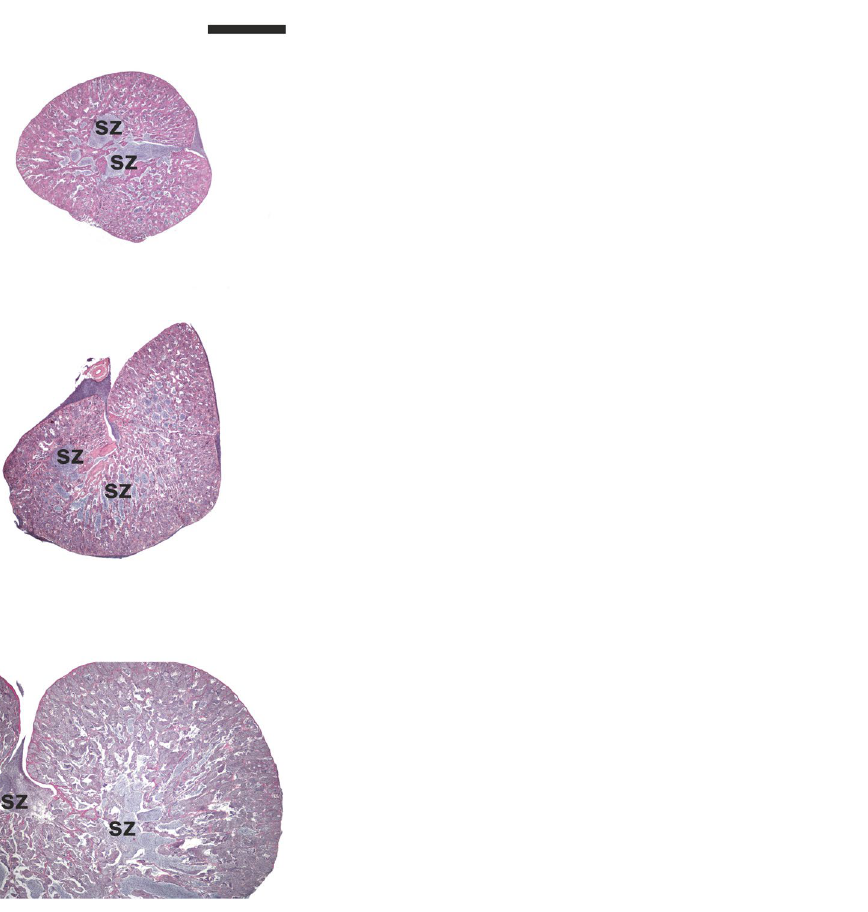
A relative quantification of anti-PCNA positive single type A spermatogonia and spermatocysts (cysts con- taining spermatogonia or primary spermatocytes) in the three experimental groups was undertaken (Fig. 6; Sup- plementary File S1). No statistically significant difference was observed in the density of anti-PCNA positive sin- gle type A spermatogonia and anti-PCNA positive spermatocysts between the two CONTROL groups (98.2 ± 47.2 vs 121.3 ± 52.9 n/mm 2 , P = 0.38 and 988.8 ± 251.5 vs 1179.1 ± 113.9 n/mm 2 , P = 0.11, respectively). The TREATED group had a significantly lower density of anti-PCNA positive single type A spermatogonia (12.4 ± 4.8 n/mm 2 ) (Fig. 6a) and a significantly higher density of anti-PCNA positive spermatocysts (1449.5 ± 279.2 n/mm 2 ) (Fig. 6b) compared with both CONTROL groups ( P < 0.05 in all comparisons). All the analysed testes showed apoptotic germ cells in the tubular compartment. The TUNEL reaction involved mainly single A spermatogonia and spermatogonia contained in cysts. When apoptosis involved a spermatocyst, all the spermatogonia contained in the cysts were apoptotic (Fig. 7). A high level of apoptosis was observed in the CONTROL groups and apoptotic cells were observed in most of the seminiferous tubules (Fig. 7a) whereas TUNEL-positive germ cells were rarely observed in the TREATED group (Fig. 7b). In fact, the semi-quantitative analysis of apoptotic cell density showed that the surface occupied by apoptotic germ cells was significantly lower in the TREATED group (1700.8 ± 297.3 μm 2 /mm 2 ) compared with both CONTROL 0 (58,799.8 ± 12,903.7 μm 2 /